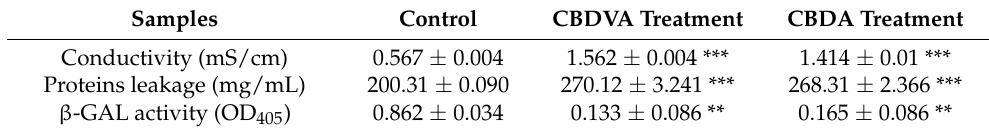
Table 4. The analysis of cell membrane permeability of E. coli treated by CBDVA and CBDA at MIC. Samples